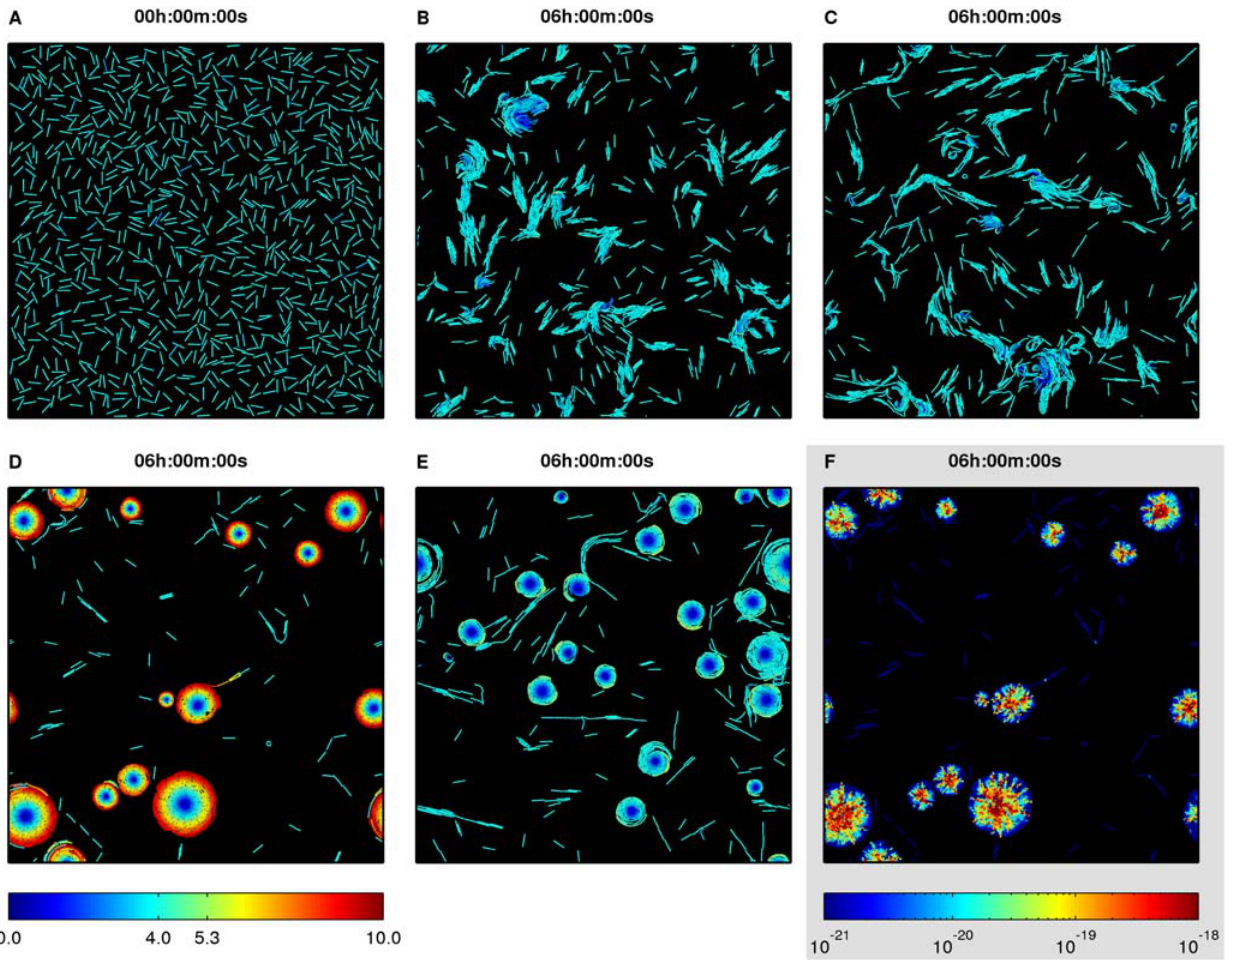
Fig 2. Effect of short-range guiding forces on cell movement patterns in a low-density population of flexible cells. (A) Initial random cell configuration. (B-E) Final configuration of a population at 6 h (B) non-guided cells, (C) cells with passive following, (D) cells with active following, (E) cells with head-to-tail adhesion. In (A-E) color indicates speed of individual cells (colorbar at the bottom left, μ m (cid:2) min − 1 ). (F) Strain energies due to cell overlap in circular aggregates of cells with active following (colorbar at the bottom right, J).